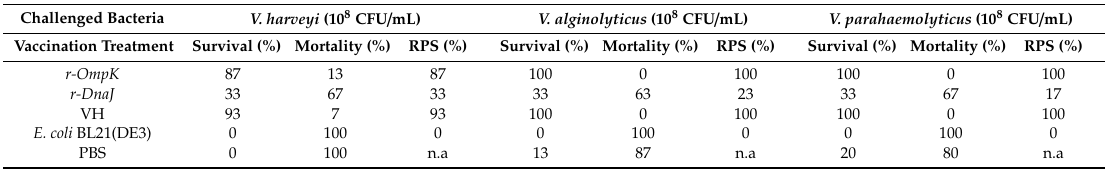
Table 4. Relative percentage survival (RPS) of vaccinated Lates calcarifer at 72 h post infection with multiple pathogenic Vibrio strain.